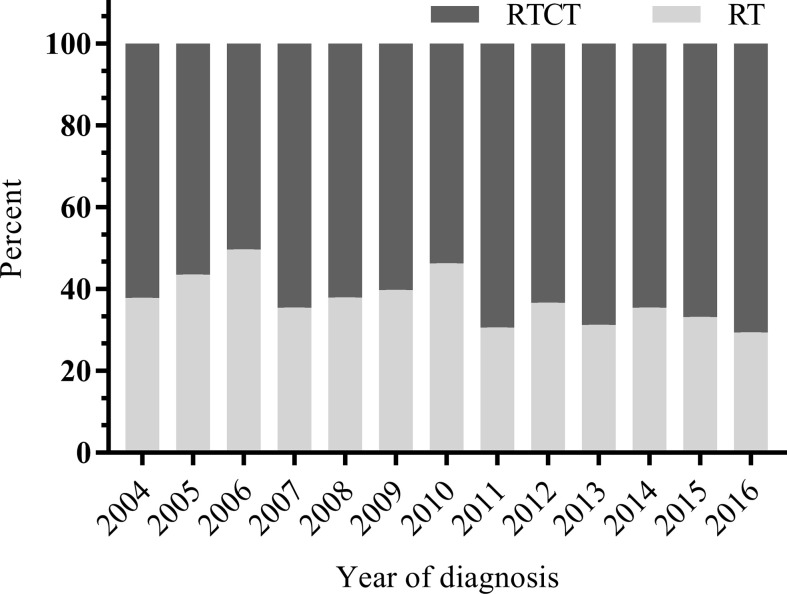
Distribution of RTCT versus RT by year from 2004 to 2016. On average, more than 60 percent of patients who underwent radiation received chemotherapy between 2004 and 2016, and the percentage increased slightly in recent years. RT, radiotherapy; RTCT, radiotherapy plus chemotherapy.